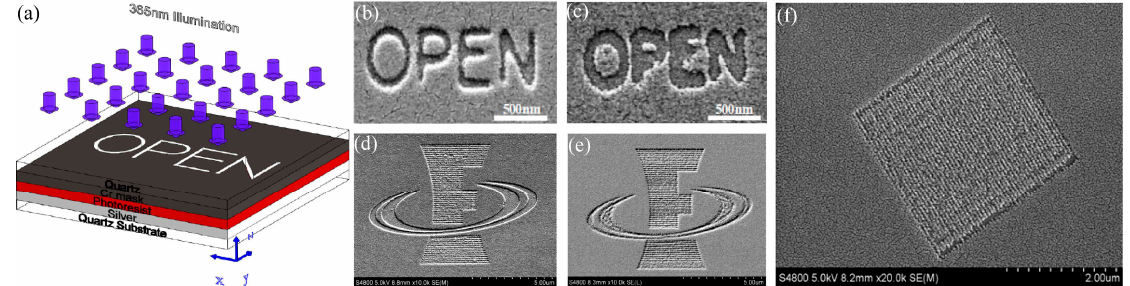
Figure 27. ( a ) Schematic structure of plasmonic reflective lens lithography; ( b , d ) Plasmonic reflective lens lithography imaging and ( c,e ) conventional near-field imaging lithography. Feature size of the pattern is approximately 50 nm. ( f ) SEM picture of 32 nm half-pitch pattern for reflective plasmonic lens lithography. Reproduced from: [23], Copyright © 2013, OAS.